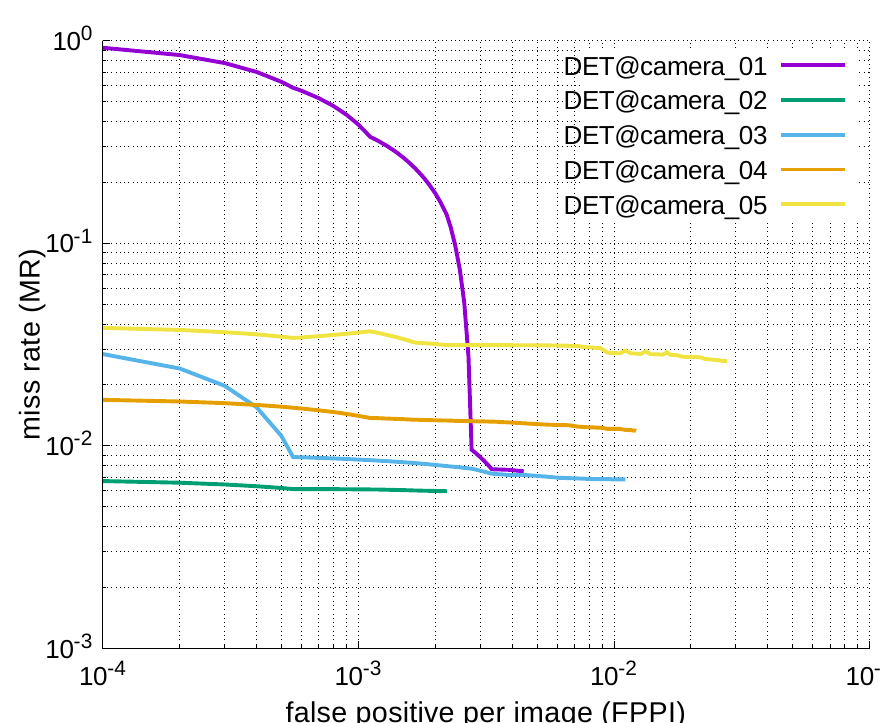
Figure 26. DET curves @ Cameras_01–05, informed-filters, some